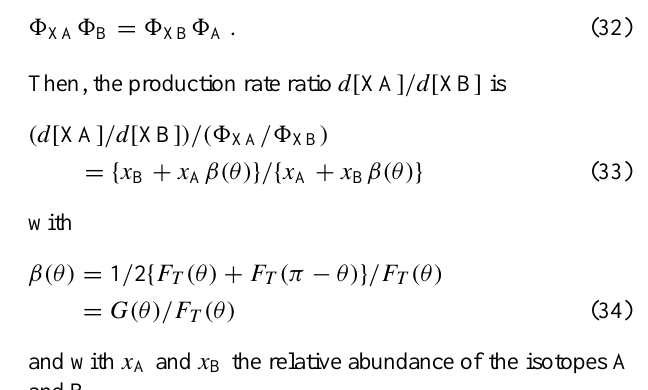
undistinguishable. The domain 2 = [ θ 1 ,θ 2 ] marks the domain of